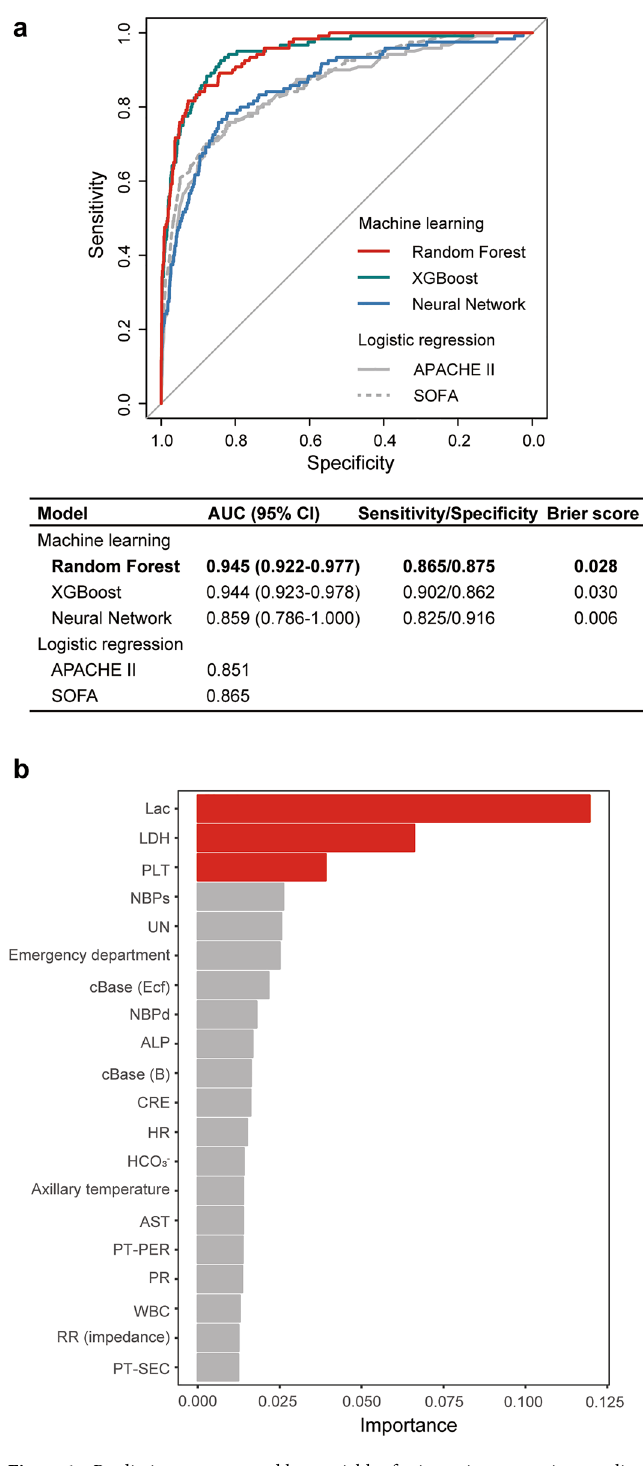
Figure 1. Predictive accuracy and key variables for intensive care unit mortality in the test cohort. ( a ) ROC curves and AUCs for ICU mortality were obtained from machine learning methods (Random Forest, XGBoost and Neural Network) and logistic regression. ( b ) Relative importance of variables for ICU mortality in Random Forest. Lac, LDH, and PLT had the highest importance for the precise prediction of ICU mortality. ROC receiver operating characteristic, AUC area under the curve, CI confidence interval, ICU intensive care unit, APACHE acute physiology and chronic health evaluation, SOFA sequential organ failure assessment, Lac lactate, LDH lactate dehydrogenase, PLT platelet count, NBPs non-invasive systolic blood pressure, UN urea nitrogen, cBase (Ecf) standard base excess, NBPd non-invasive diastolic blood pressure, ALP alkaline phosphatase, cBase (B) actual base excess, CRE creatinine, HR heart rate, AST aspartate aminotransferase, PT-PER prothrombin time (%), PR pulse rate, WBC white blood cell, RR (impedance) impedance respiratory rate, PT-SEC prothrombin time